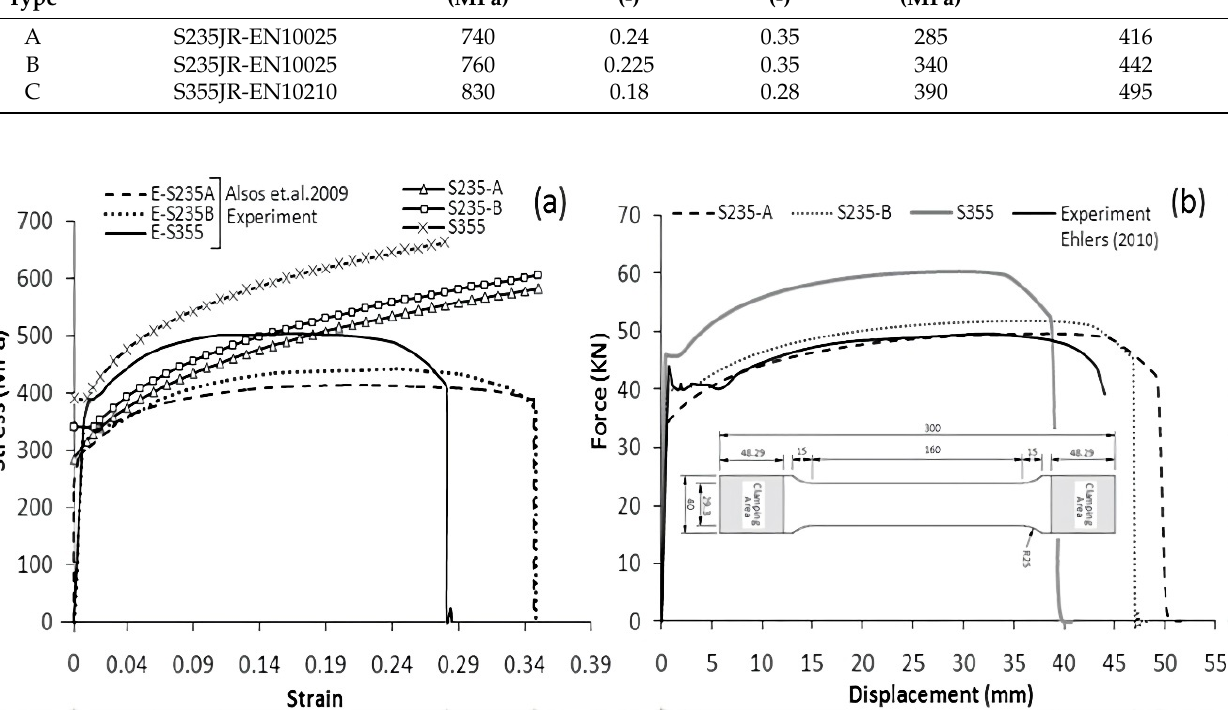
Figure 12. ( a ) The stress-strain curve. ( b ) The tensile test force-displacement curve [51]. Table 6. The material properties of steel based on [47,48] which were obtained experimentally.